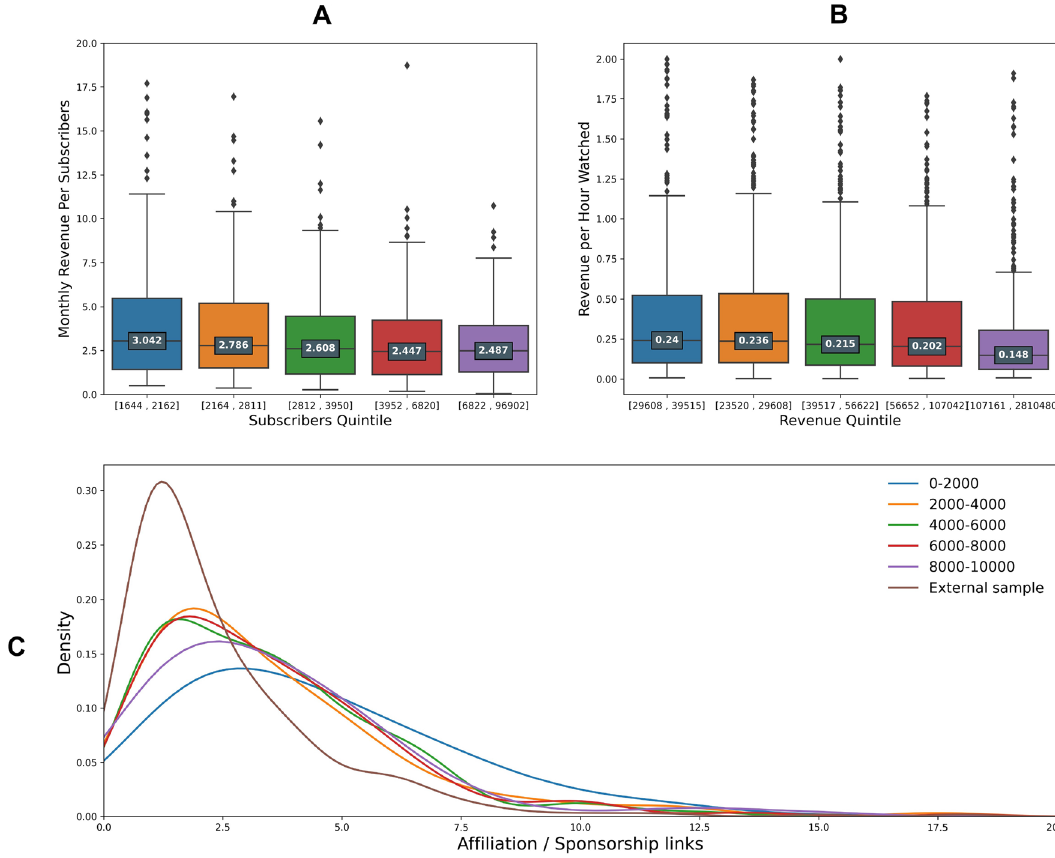
Figure 3. Audience rentability: Streamers grouped by revenue against type of revenue stream (subscriptions; ads; external monetization). ( A ) Box-plot of the streamers grouped in quintiles for number of subscribers against the average revenue per subscribers for a sample of 1000 streamers (source TwitchTracker 27 ), illustrating the diminishing returns per sub of income in the Twitch platform. ( B ) Boxplot illustrating the revenue of the top 10,000 streamers grouped in quintiles against revenue per hours watched (hours collectively consumed by the entirety of viewers; source for hours watched: Twitch 45 ). Users belonging to the richer group monetize less per hour watched. ( C ) KDE plot describing the number of affiliation or sponsorship URLs found in channel description (Directly bellow every stream page ; Source: Twitch 45 ) for a sample of 1333 streamers grouped by revenue (external sample refers to streamers outside of the top 10,000). We see that the top 2000 streamers have an higher average (0–2000 ≈ 3.7; 2000–4000 ≈ 2.8; 4000–6000 ≈ 2.4; 6000–8000 ≈ 2.5; 8000–10,000 ≈ 2.7; External sample ≈ 2.2 ) as well as fatter tail distribution which is confirmed by looking at the standard deviation (0–2000 ≈ 4.1; 2000–4000 ≈ 2.8; 4000–6000 ≈ 2.4; 6000–8000 ≈ 2.6; 8000–10,000 ≈ 3.8; External sample ≈